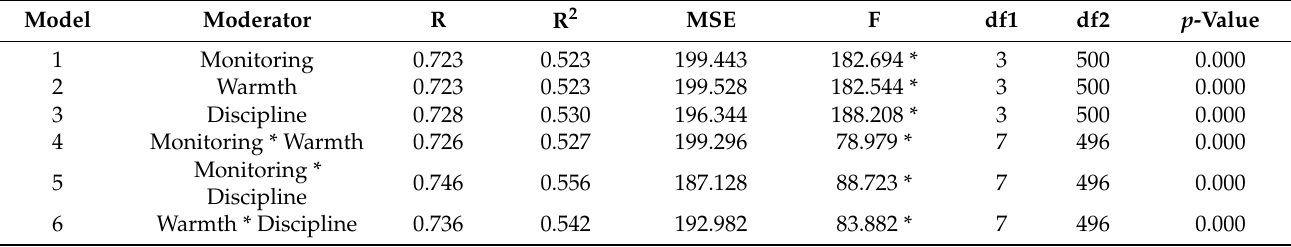
Table 4. Model summary.